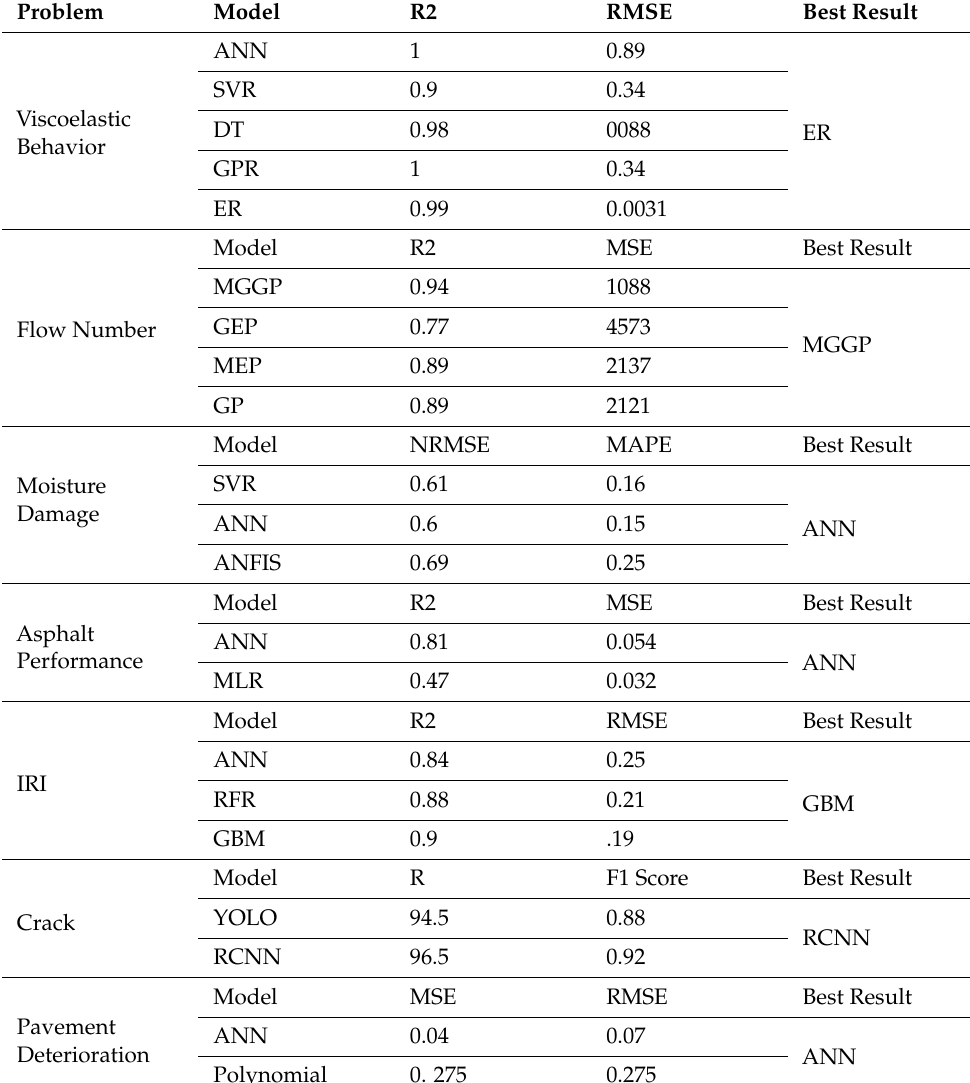
Figure 5. Chart of publishers of the extracted research. Table 5. Comparison of